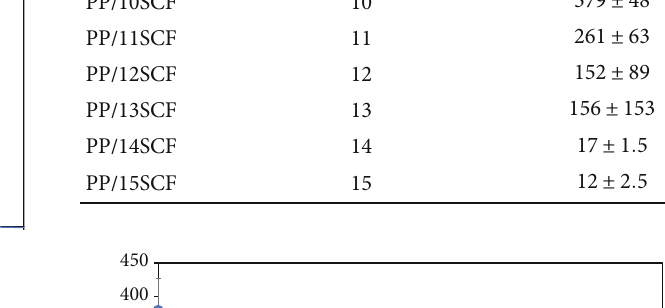
Figure 4: Strain at break of the PP/SCF composite with 0 – 40 wt% of SCF.